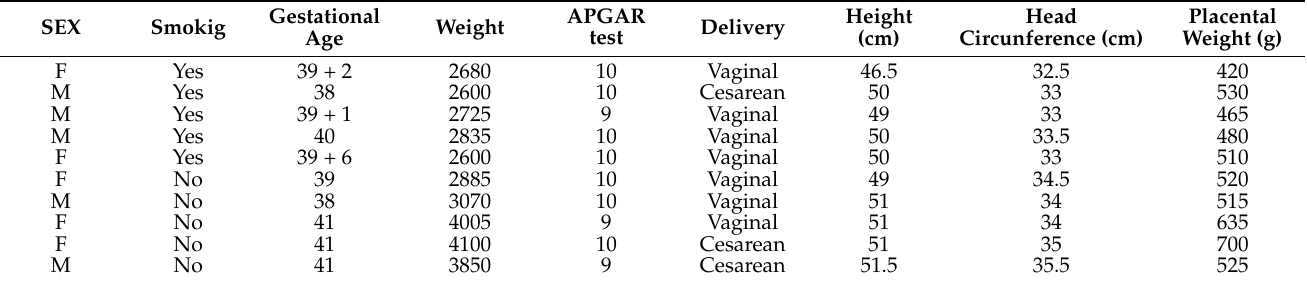
Table 1. Main clinical characteristics of the